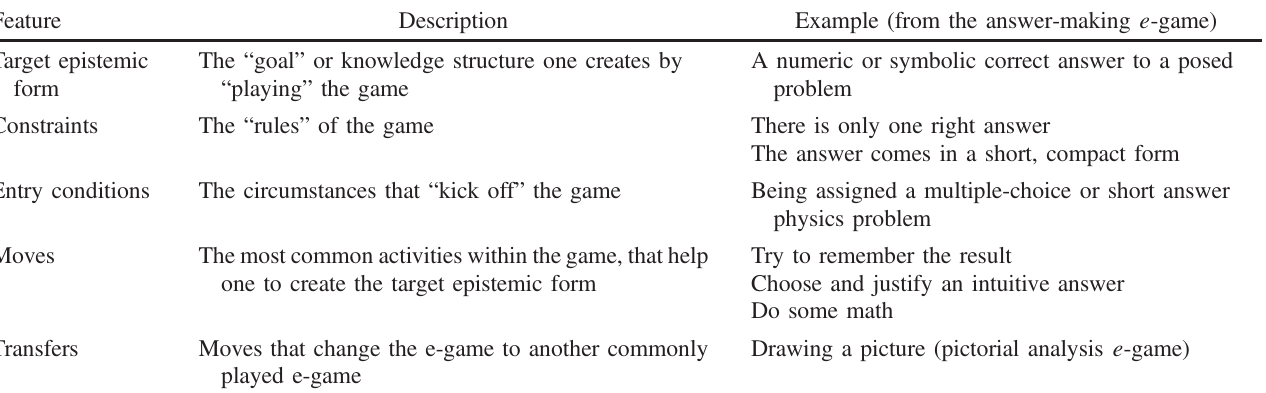
TABLE I. Features of epistemic